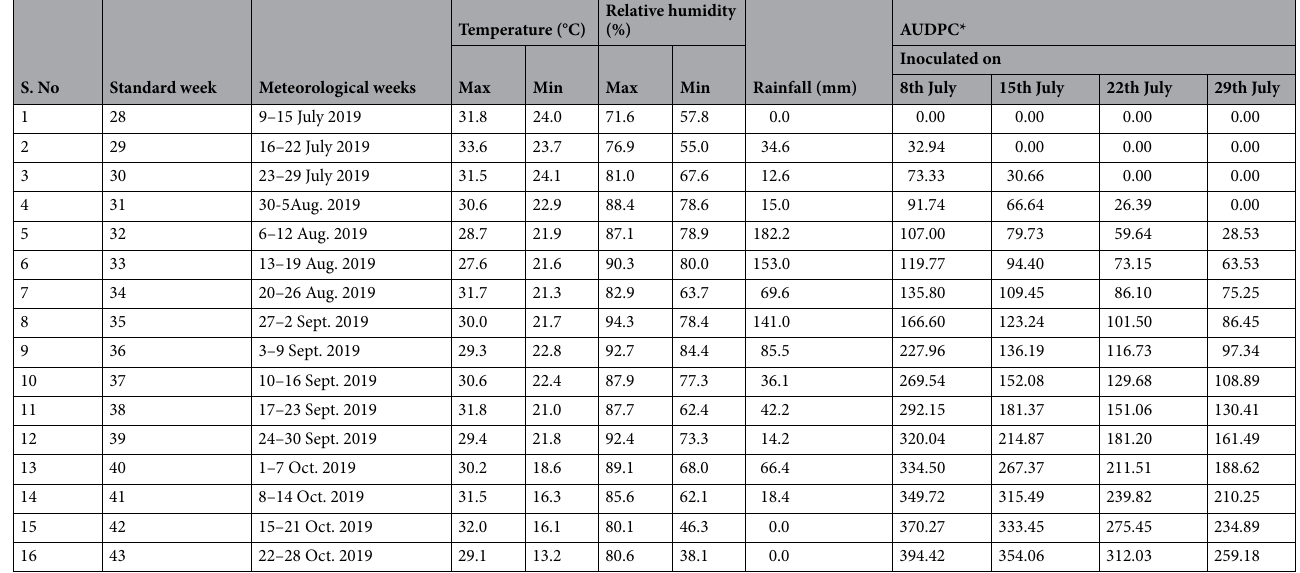
Table 6. Progression of Alternaria leaf spot on soybean in relation to weather parameters in different dates of sowing under epiphytotic conditions during Kharif , 2019. *Mean of three replications, Inoculation started 21 days after sowing of each date. *Observation started 7th days after inoculation and at weekly intervals, 1st sown-18th June, 2nd–25th June, 3rd–02th July, 4th–09th July 2018.